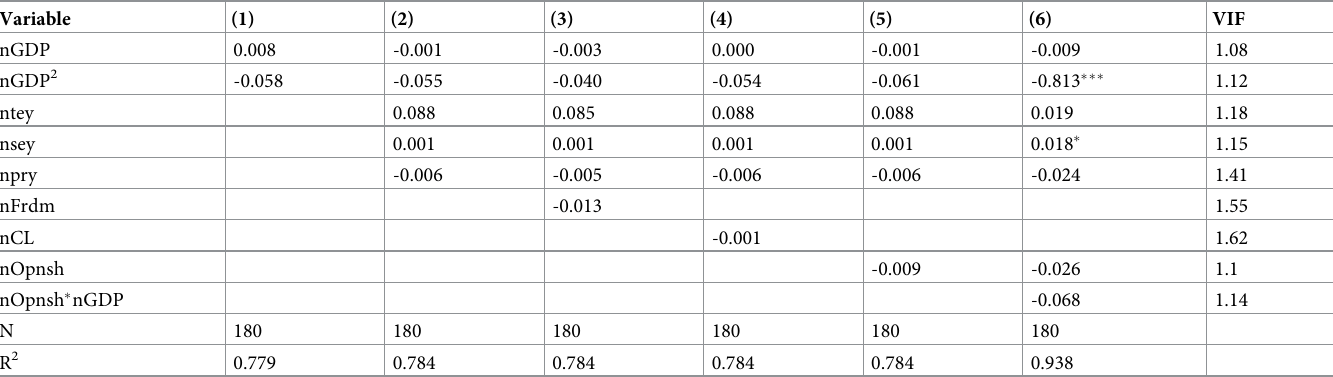
Table 7. Replication results for Barro (2000) with the quasi-cross-sectional